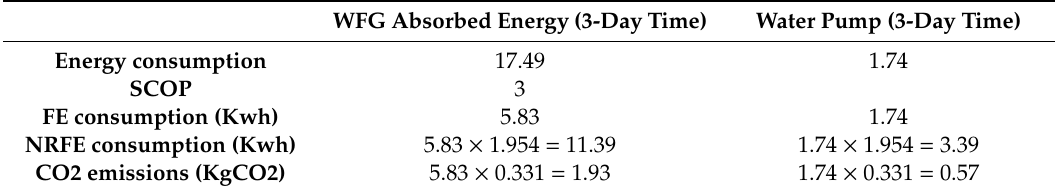
Table 3. Final energy analysis. Sample summer days: 23 / 08 / 2010, 24 / 08 / 2010, and 25 / 08 /